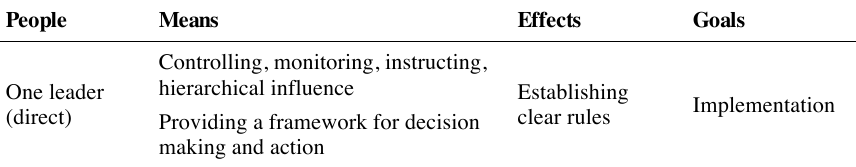
Establishing Implementation clear rules Ideation Innovative climate Product innovation Increased conflict level